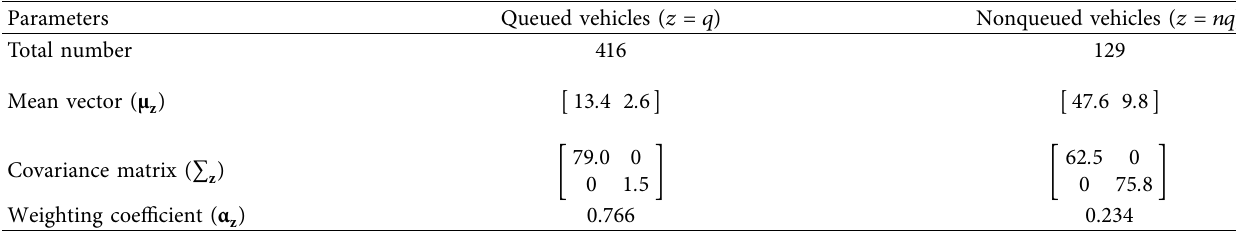
Table 1: Parameters of